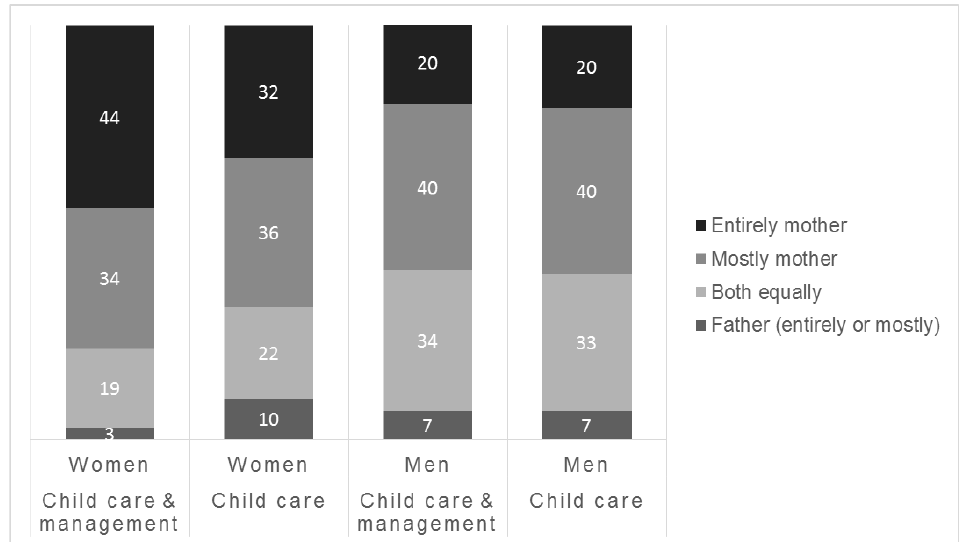
Figure A.1 : Division of care during the coronavirus